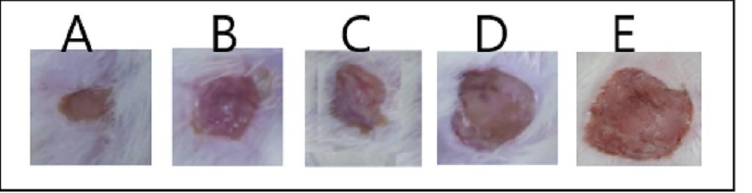
Figure 5. Mean burn wound diameter for different formulations: optimum Gr-PV-NE ( A ), Gr-NE ( B ), PV-NE ( C ), PV-Gr mixture ( D ), and normal saline ( E ). IL-6 Level